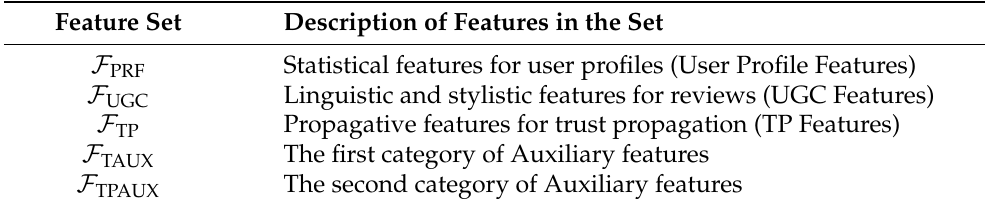
Table 2. Sets of features used in the proposed